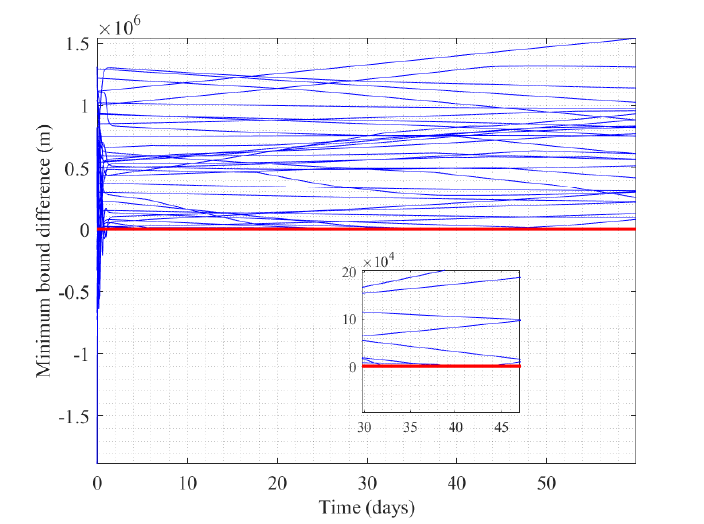
Figure 15. The differences in minimum bounds away from the corresponding constraints. Red line is zero-value standard. Blue lines are minimum bound differences.